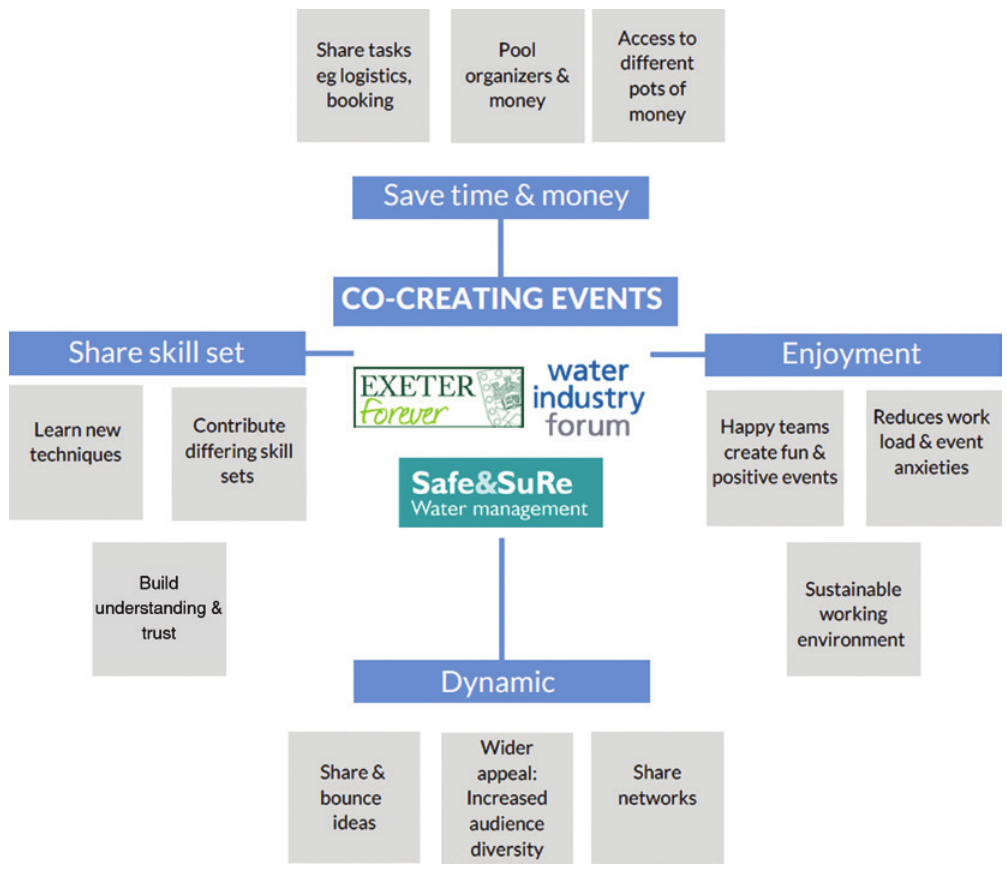
figure 5: The benefits of co-creating events to communicate